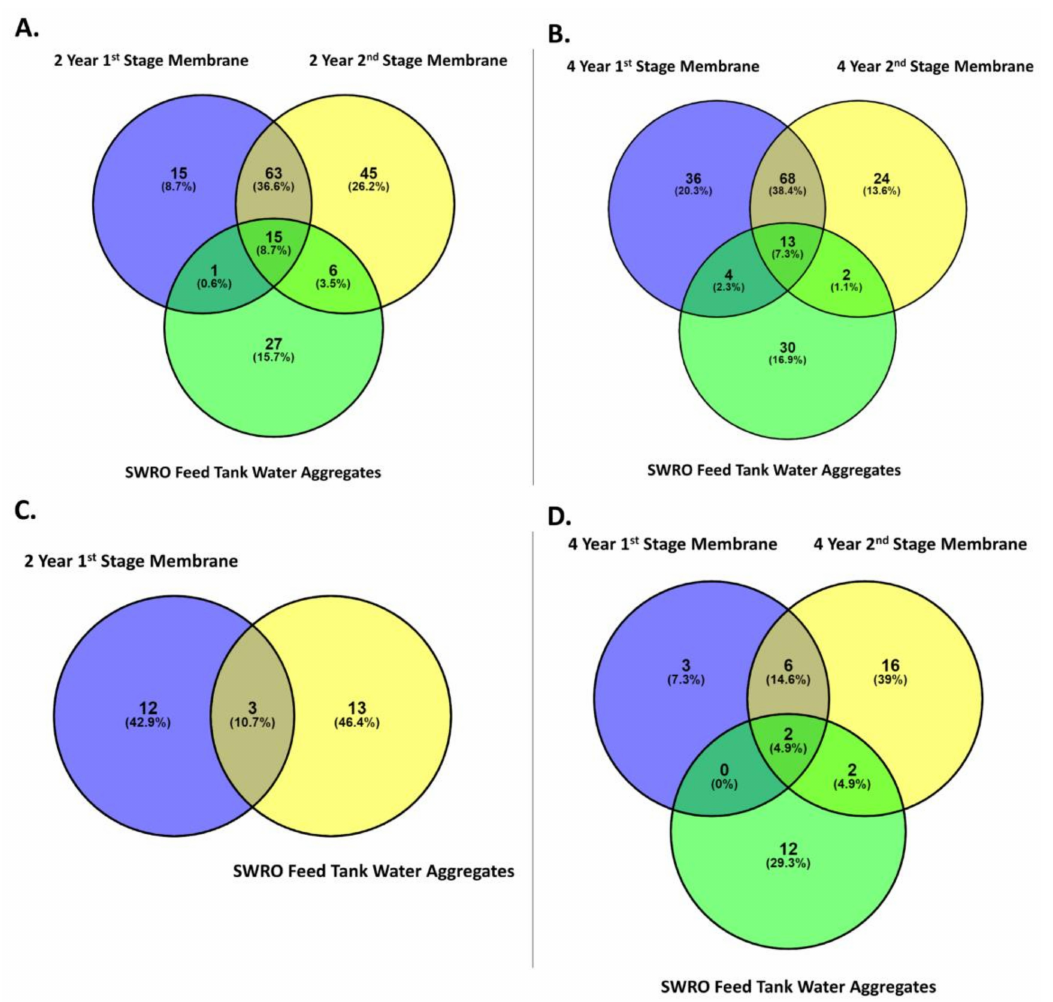
Figure 9. Venn diagram displaying the overlap between the communities of the aggregate and the 1st and 2nd stage membranes. ( A ) Prokaryotic communities in the SWRO feed tank water aggregates, and the 1st stage and 2nd stage membrane after two years’ service and ( B ) the prokaryotic communities in the SWRO feed tank water aggregates and 1st stage and 2nd stage membranes after four years of service. ( C ) The eukaryotic communities in the SWRO feed tank water aggregates and 1st stage membrane after two years’ service and ( D ) eukarotic communities of the SWRO feed tank water aggregates and 1st stage and 2nd stage membranes after four years of service. Core OTUs, identified in all sampling sites; variable OTUs, identified in two or more sites but not all; unique OTUs, identified in only one